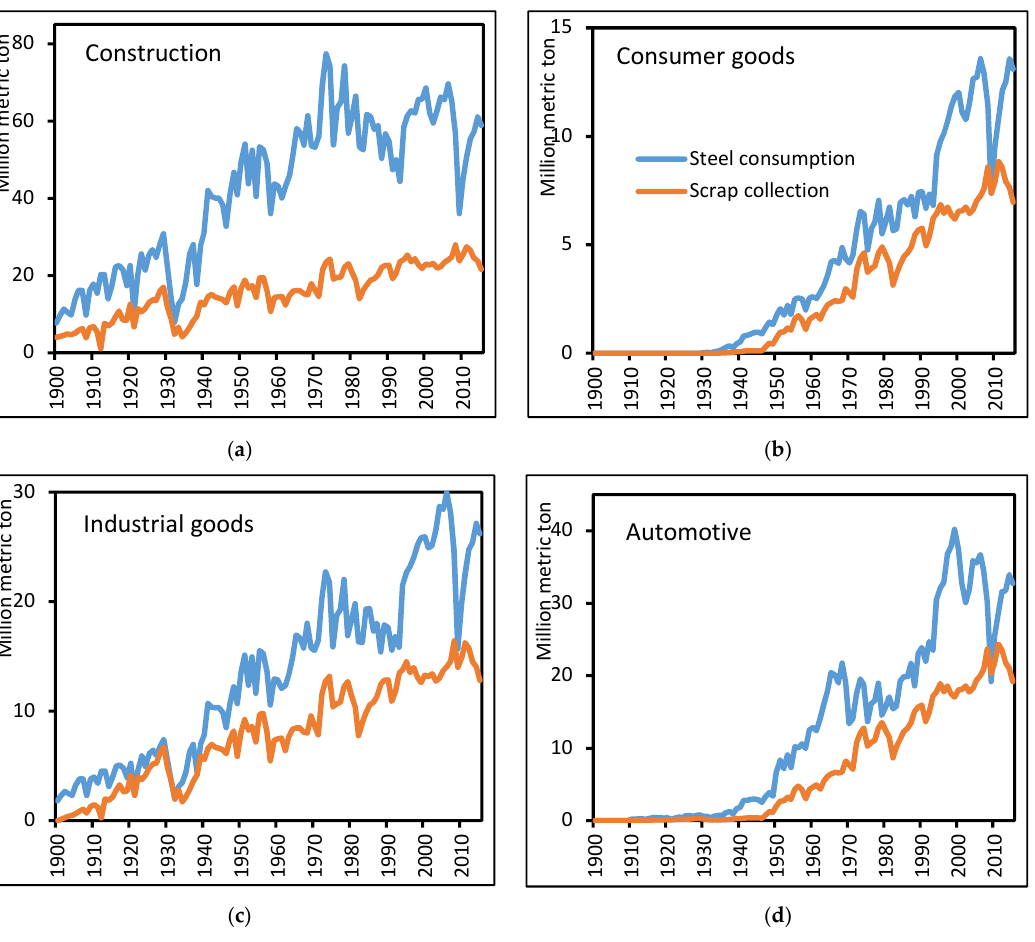
Figure 4. Input data on steel consumption and scrap collection for the following industry sectors: ( a ) construction, ( b ) consumer goods, ( c ) industry goods, ( d ) automotive sector between 1900 and 2016 in the U.S.